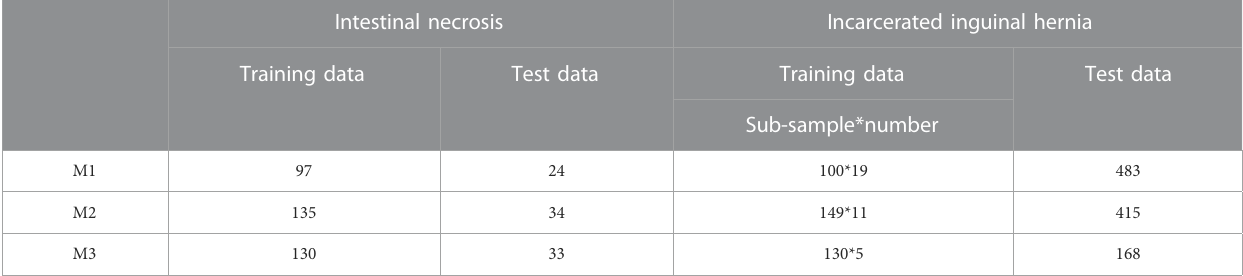
TABLE 1 Pro fi le of positive and negative